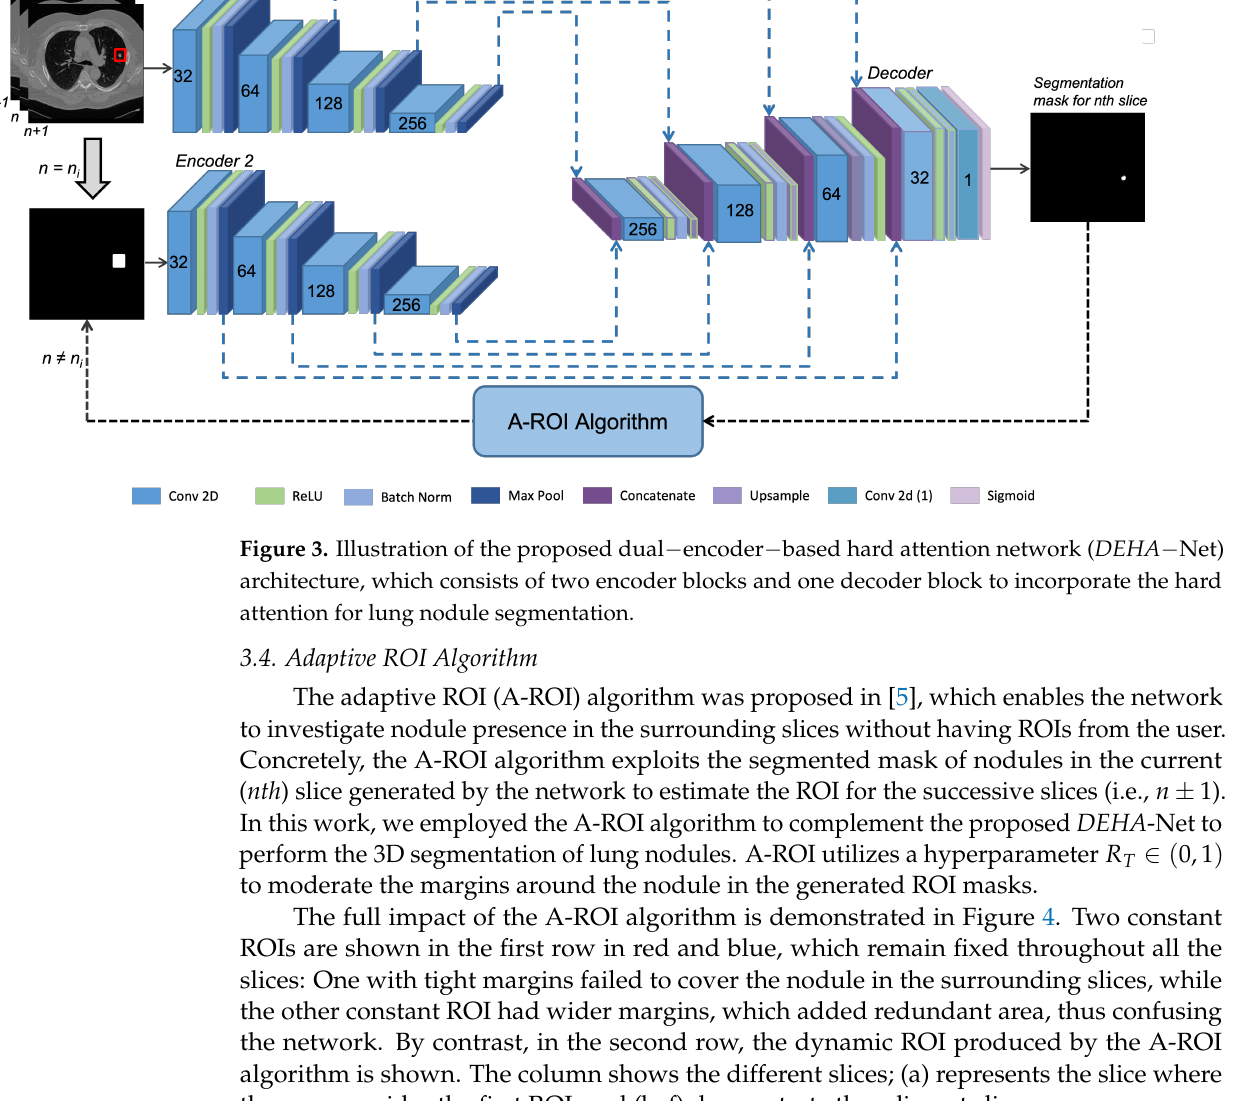
Figure 3. Illustration of the proposed dual architecture, which consists of two encoder blocks and one decoder block to incorporate the hard attention for lung nodule